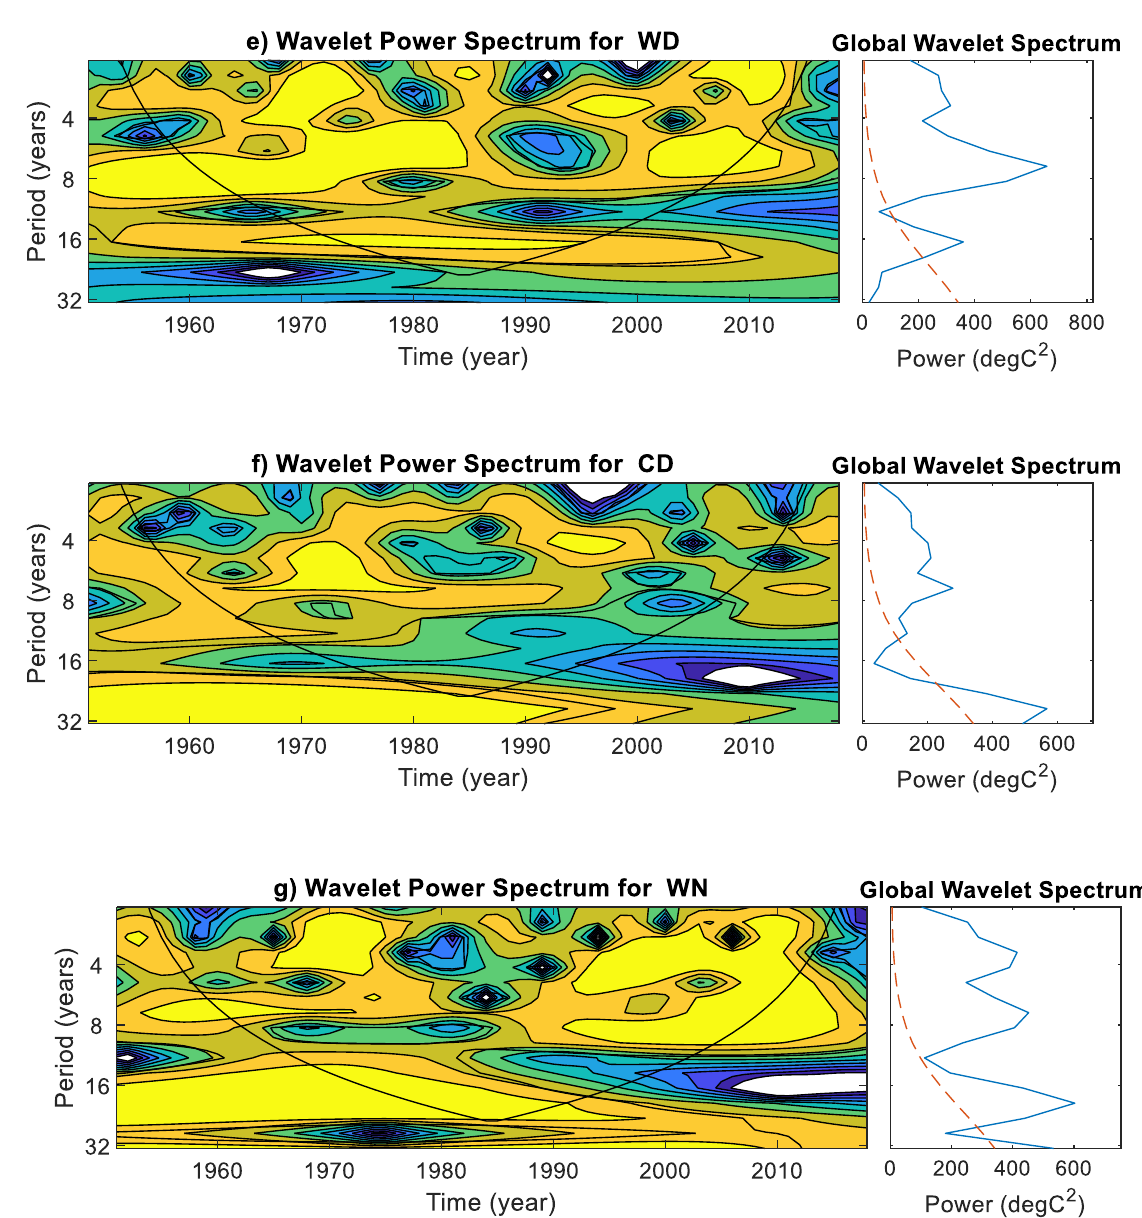
Figure 6. Continuous wavelet transformation for climate indices ( a ) R50MM, ( b ) D95P, ( c ) R20MM, ( d ) R95TOT, ( e ) WD, ( f ) CD, and ( g ) WN averaged over 38 grid points in the Gomati river basin during 1951–2018. The V shape represents the cone of influence and regions enclosed with light yellow are periods with significant power. The red color dashed line distinguishes between significant and non-significant periods. If the global wavelet spectrum curve is higher than the dashed line at a particular scale, then the period is statistically significant at the 95% confidence level.